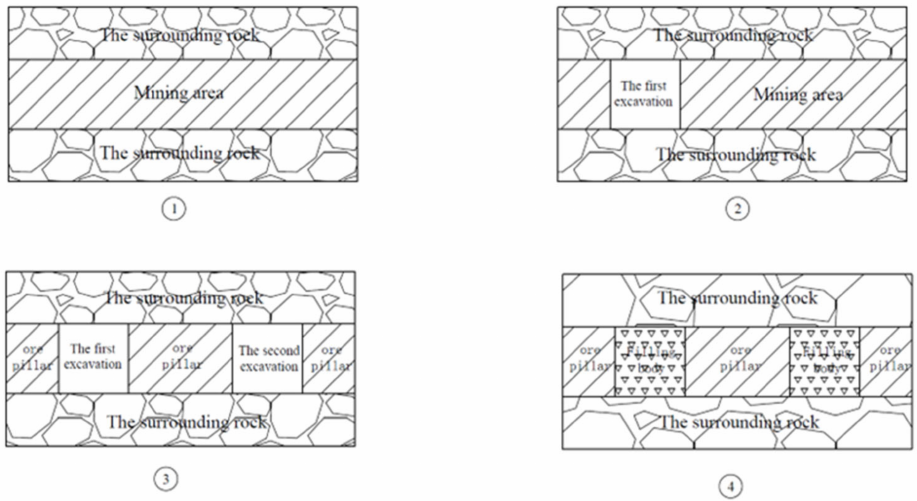
Figure 5. Section layout of ore